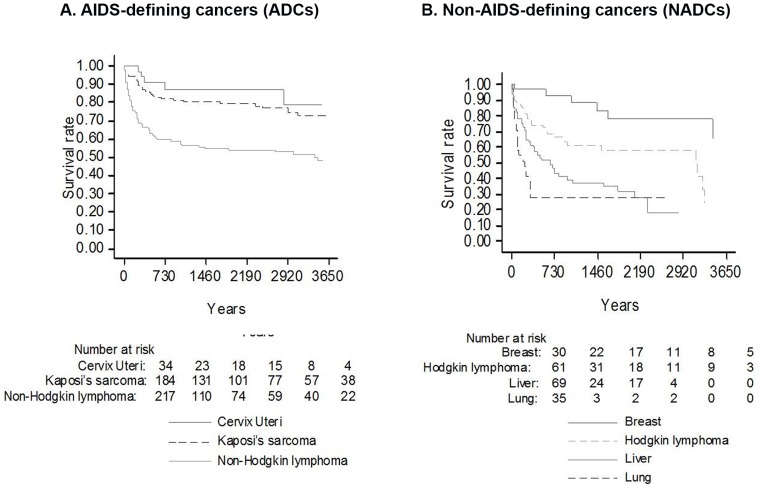
Survival curves according to specific cancer types.Panel (A) Survival probabilities according to AIDS-defining cancer (ADC) diagnosis. Overall, the median survival time from diagnosis of all ADC was 3.4 years; more specifically, the median survival time of NHL was 2.1 years, Kaposi sarcoma 4.7 years, and cervical cancer 5.1 years. Panel (B) Survival probabilities according to non-AIDS-defining cancer (NADC) diagnosis. The overall median survival time of NADC was 1.6 years; more specifically, the median survival time of liver cancer was 441 days, lung cancer 113 days, breast cancer 1624 days, and Hodgkin lymphoma 795 days.